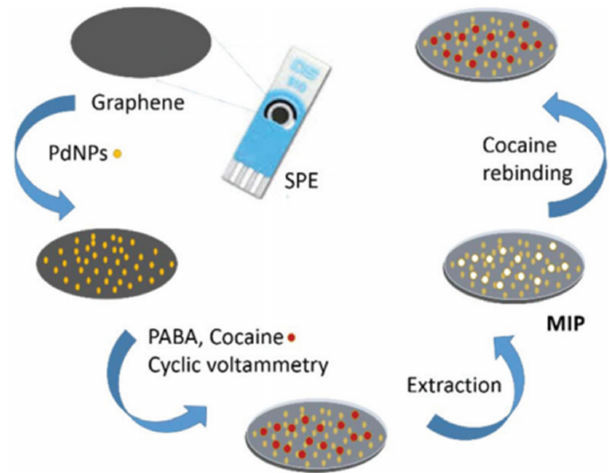
Figure 8. Synthesis of a sensor for cocaine quantification via MIP electropolymerization onto elec- trodes with graphene-modified with Pd-NPs. Taken from [71], copyright 2019, Royal Society of